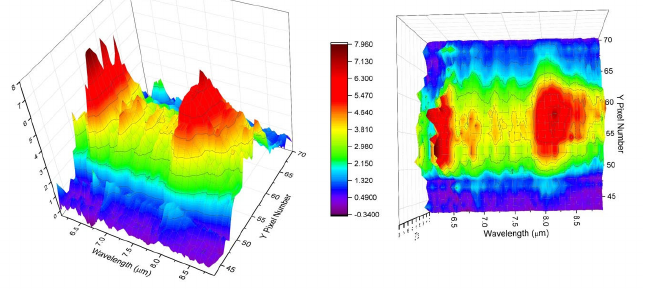
Figure 14. Calibration-corrected single-shot 2 − D LWIR LIBS spectrum of acetaminophen.